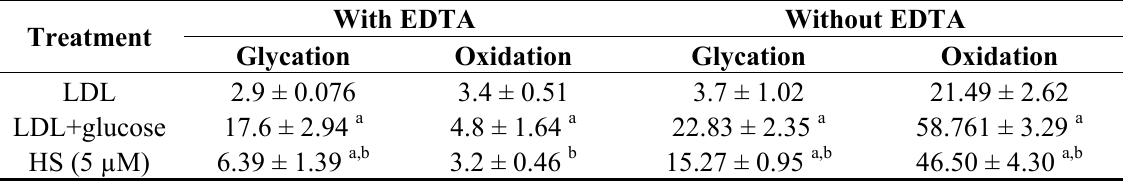
Table 6. Protective effect of 5 µM, of HS on LDL against 50 mM glucose-induced glycation and oxidation with or without 0.5 mM EDTA